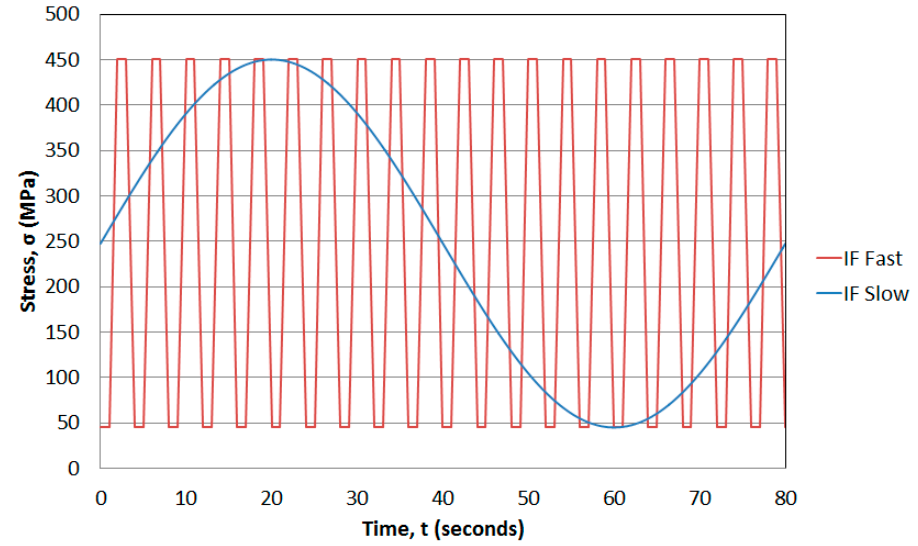
Figure 6. Stress response for ‘fast’ and ‘slow’ isothermal fatigue (IF) tests.